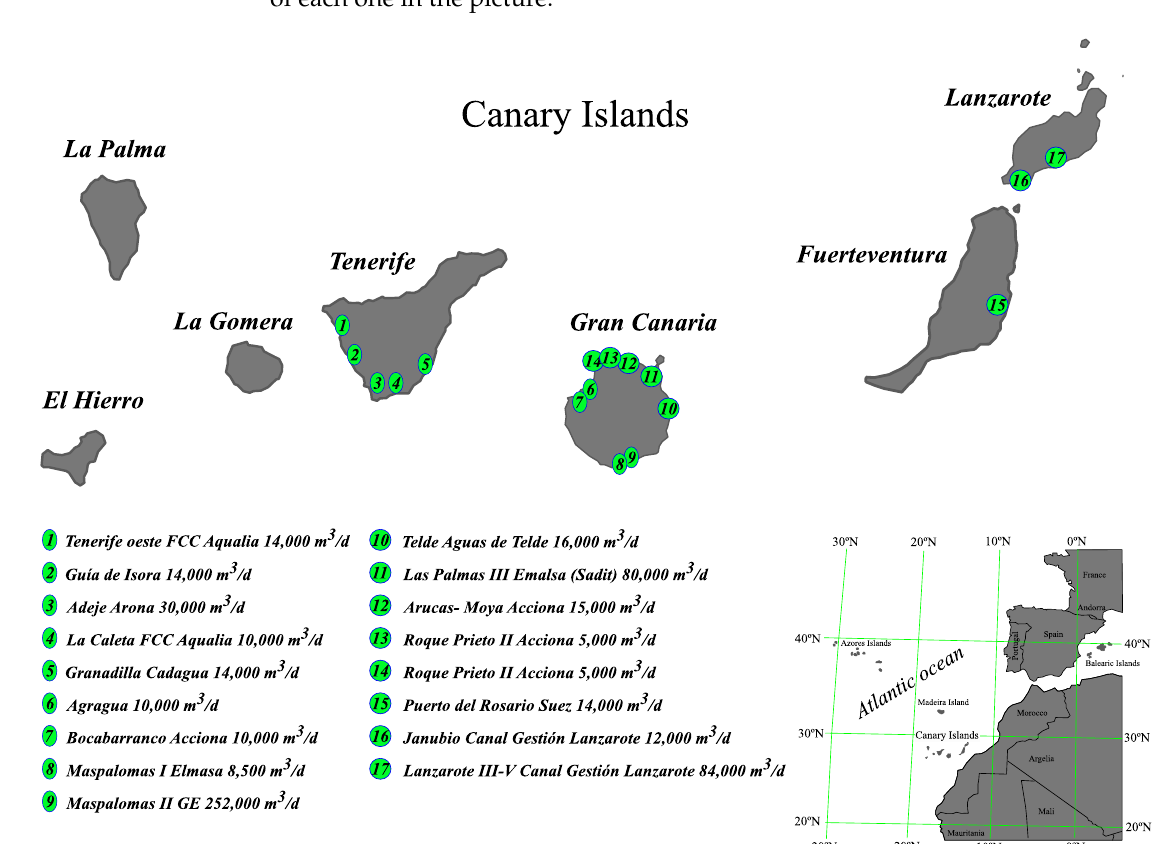
Figure 6. Most significant seawater desalination plants (2019).